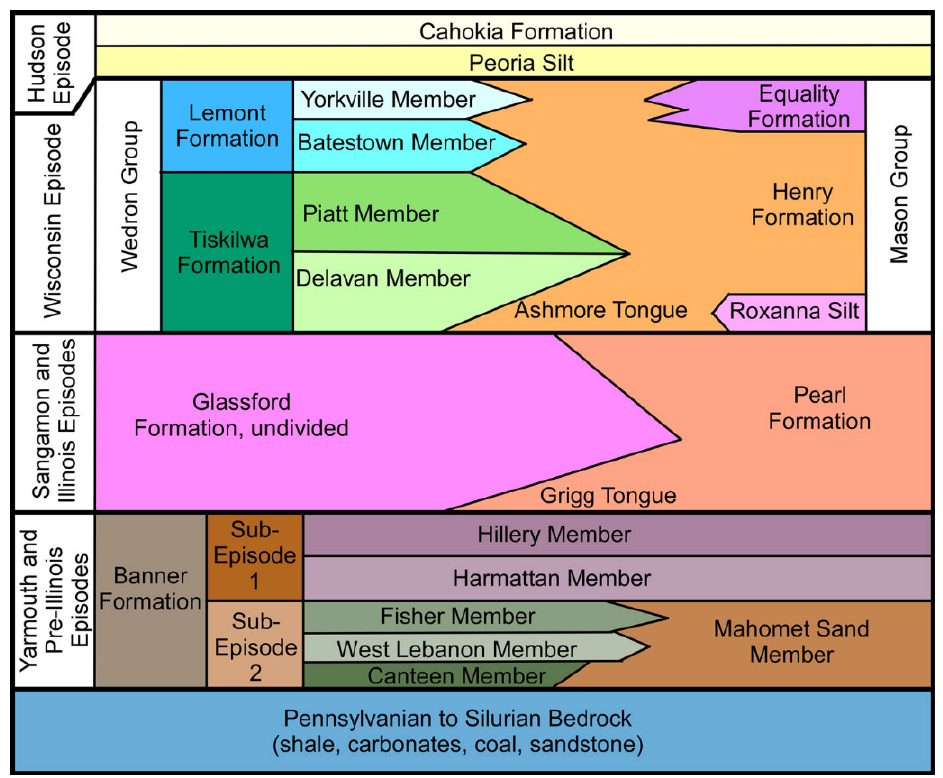
Figure 1. Map of the Mahomet Aquifer (gray area) in east-central Illinois, USA. Mapping area is highlighted by red box. Figure modified from [45].